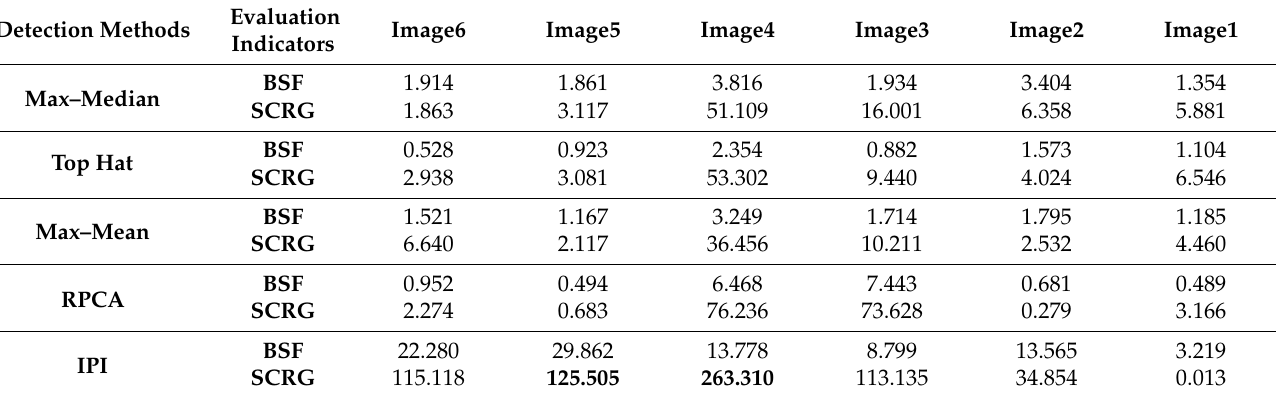
Table 4. BSF and the SCRG values obtained using the various approaches for each of the test images in Figure 4a. The best outcomes are indicated in bold.